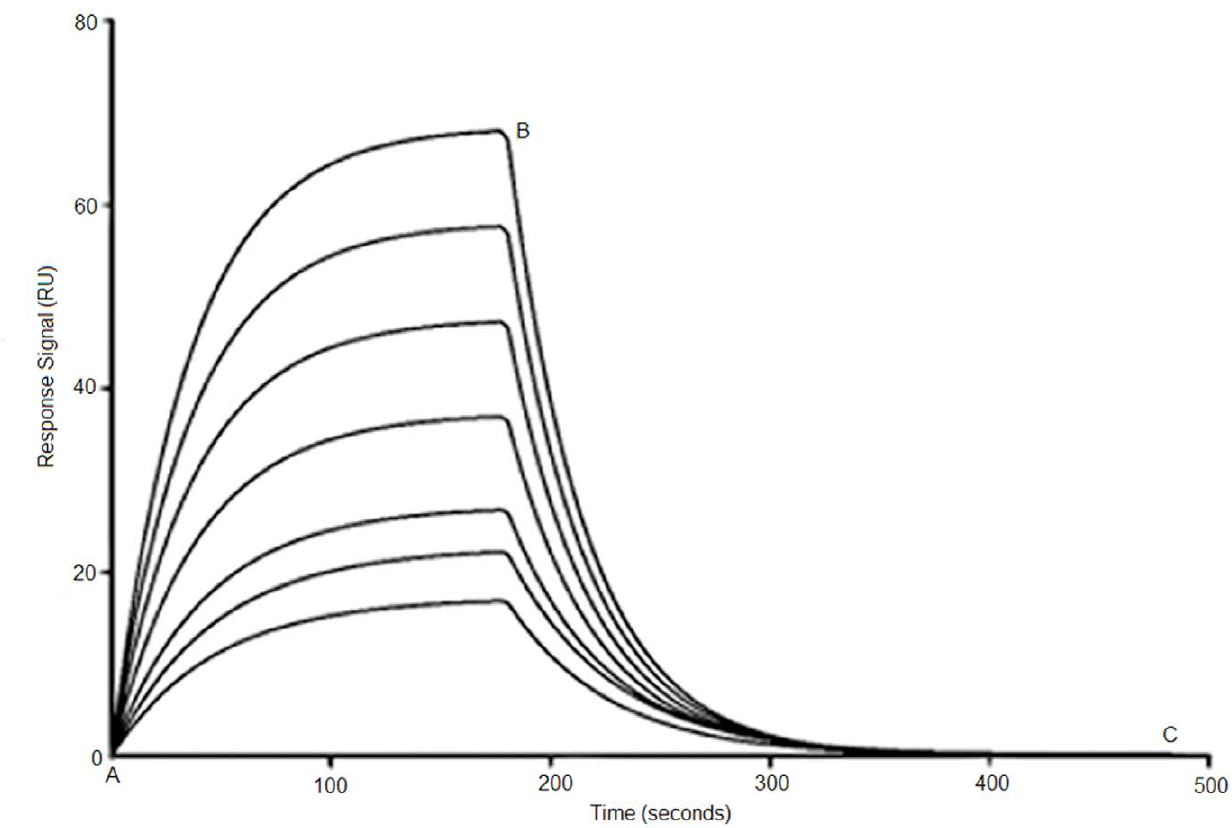
Figure 1. Typical SPR sensorgrams demonstrating interaction of aptamer with immobilized VEGF 165 protein at different concentration (bottom to top, 0.2 to 100 nM). Point A to B corresponds to association phase and point B to C corresponds to the dissociation phase in all the sensorgrams. Shown here is PS-modified SL 2 -B aptamer (K d =0.56 6 0.44 nM).